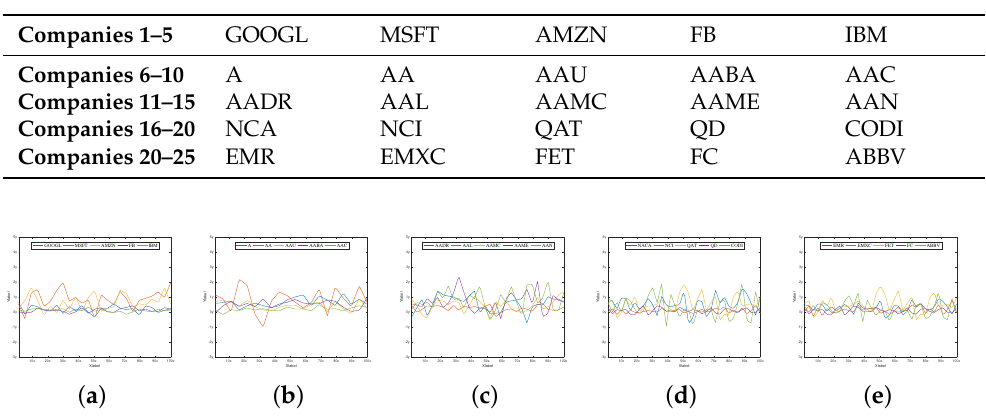
Figure 4. The return rate for all the 25 companies for 200 days of NASDAQ stock data in 2017. ( a – e ) represents the data of companies 1–5, companies 6–10, companies 11–16, companies 16–20, and companies 20–25,